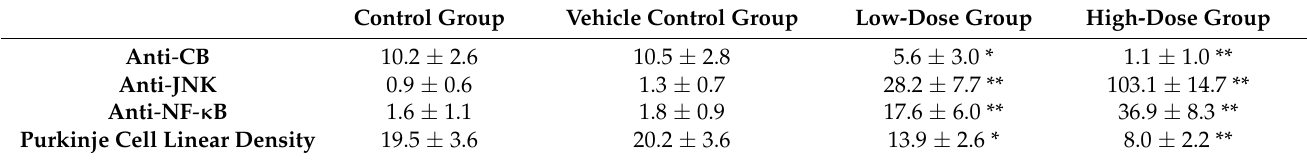
Table 3. Number of anti-JNK, anti-NF- κ B immune-stained cells, anti-calbindin D28k (CB) and Purkinje cell linear